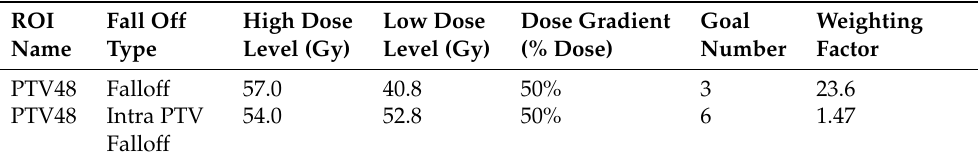
Table 4. Priority 3—Trade-off Goals (Dose Fall Off). Dose Gradient represents the percentage of the overall treatment